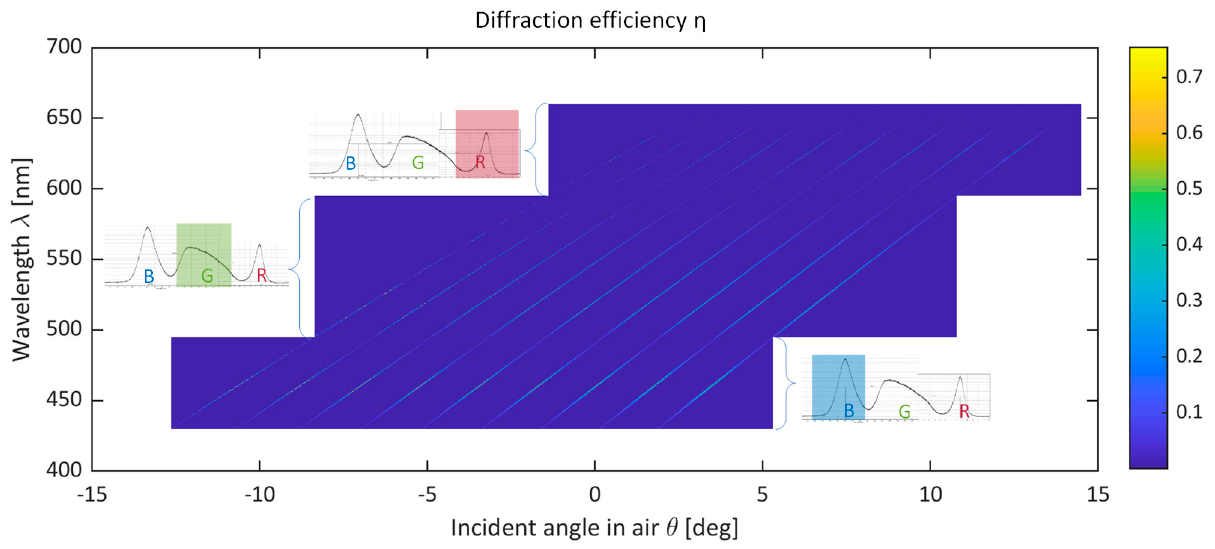
Figure 4. MVHGs diffraction efficiency analysis for blue light: ( a ) Selectivity contours for spectral maxima and ( b ) wide spectrum. MVHGs diffraction efficiency analysis for red light: ( c ) Selectivity contours for spectral maxima and ( d ) wide spectrum.